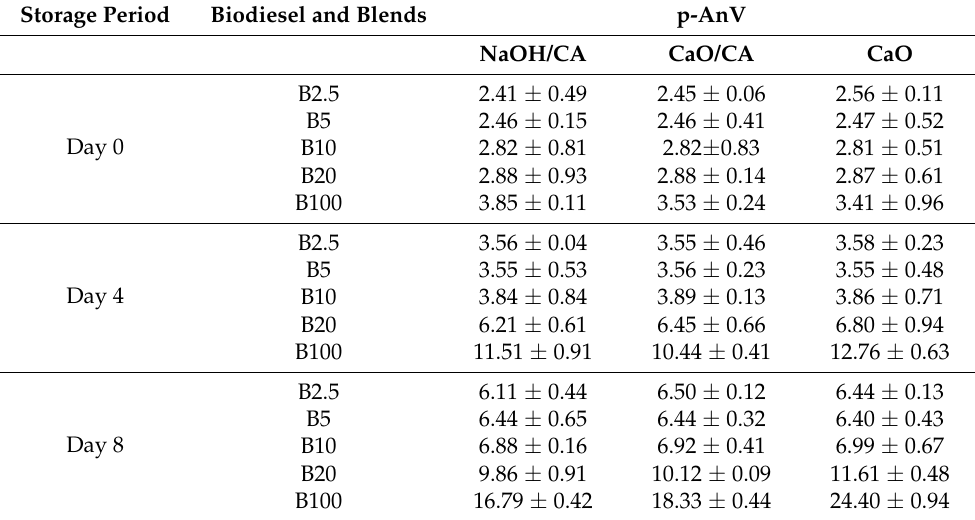
Table 3. p-Anisidine values (AnV) of biodiesel and biodiesel blends under accelerated storage at 63 ◦ C. Storage Period Biodiesel and